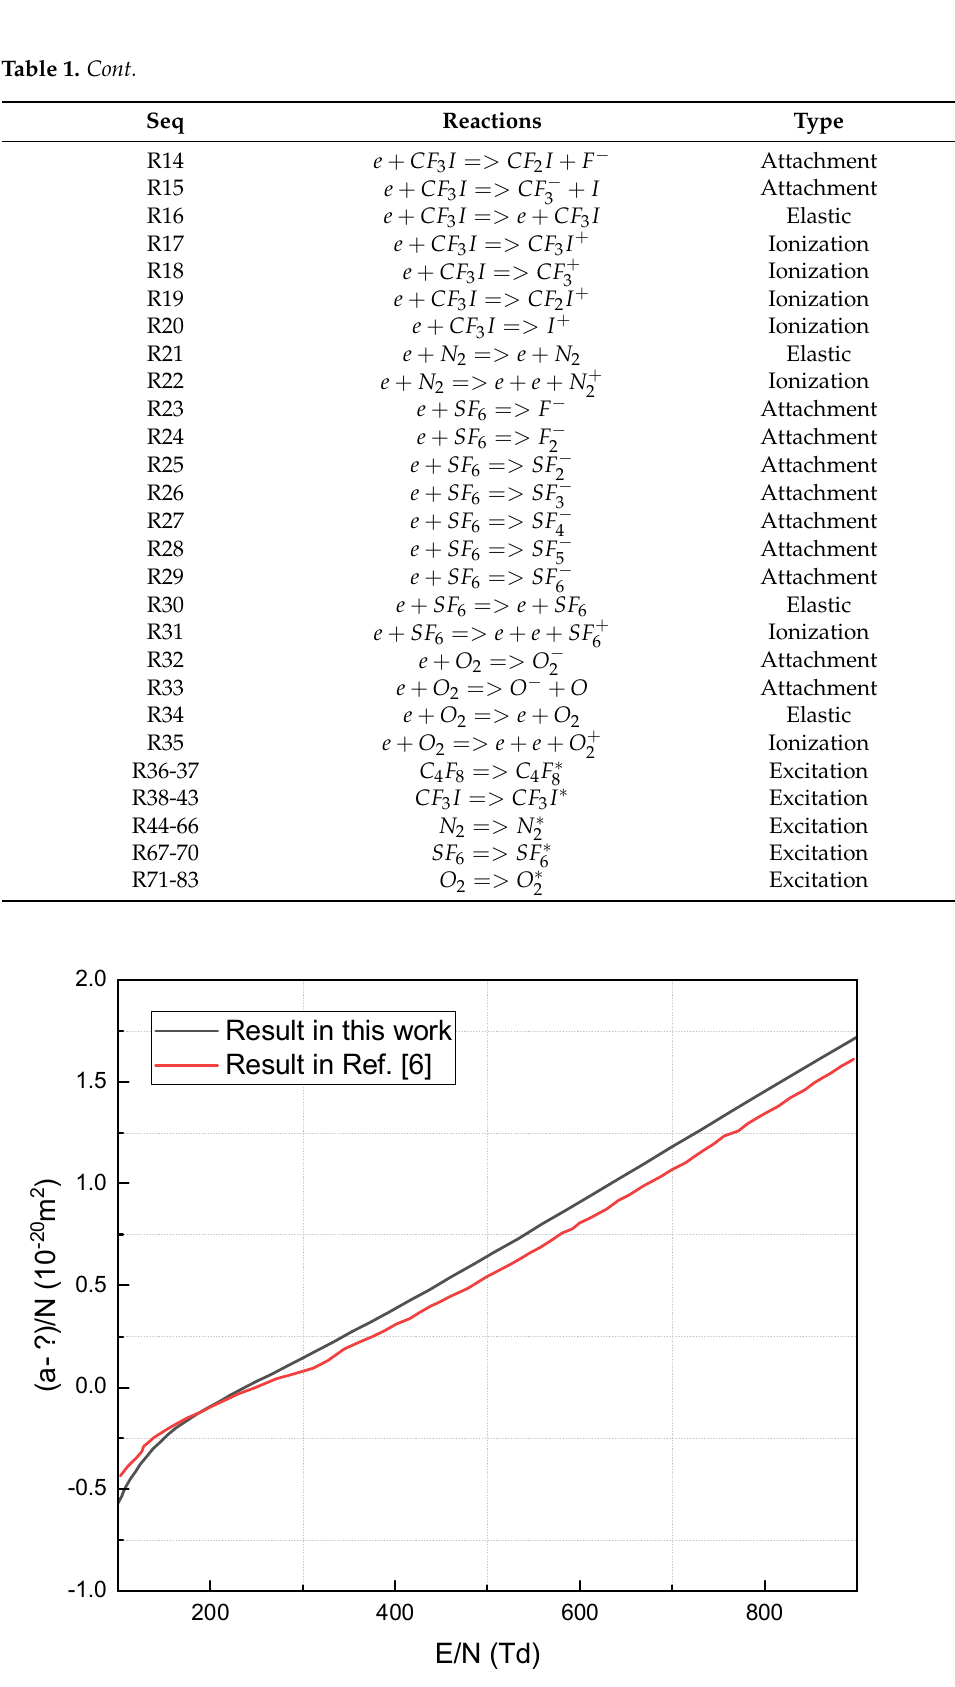
Figure 3. Reduced effective ionization coefficients of 10%c-C 4 F 8 /20%CF 3 I/70%N 2